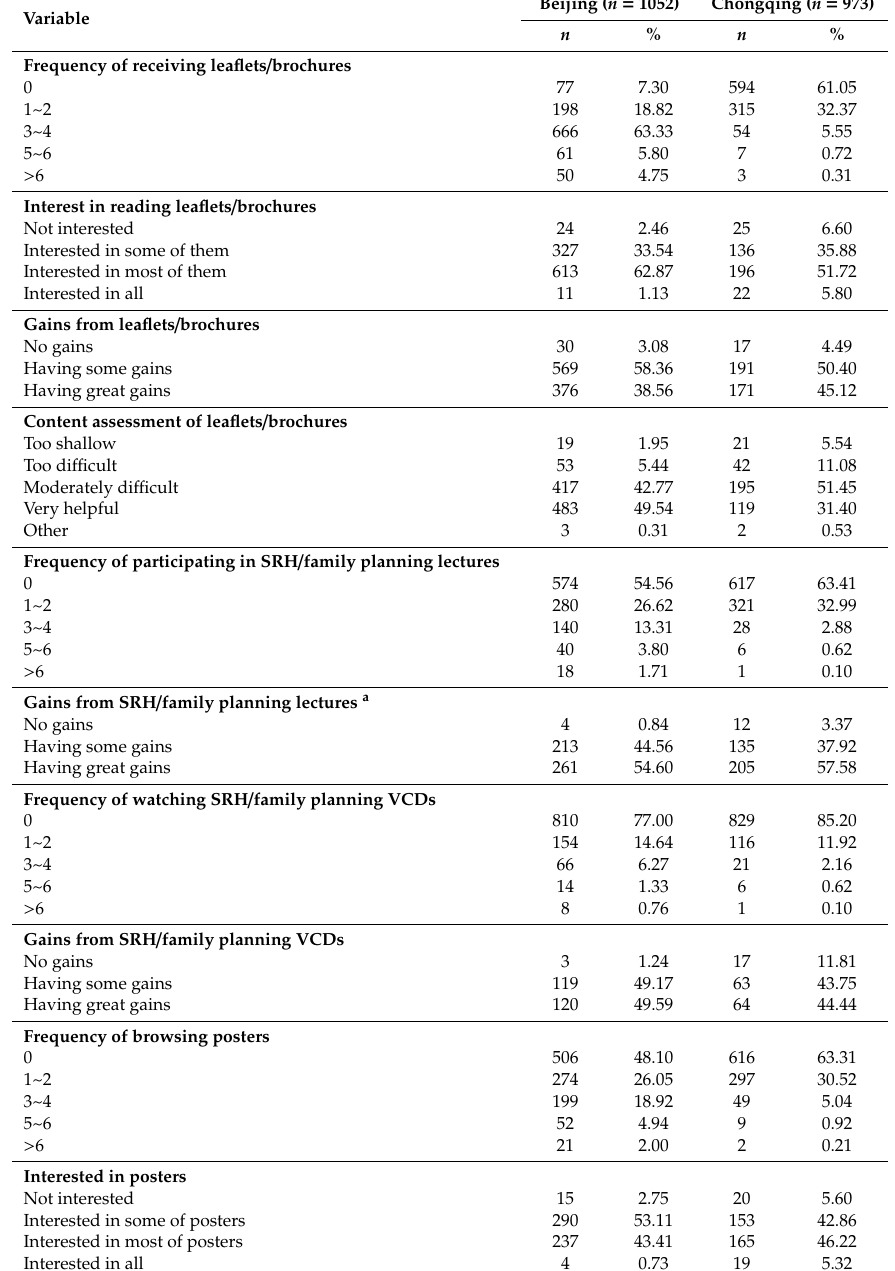
Table 1. Participation in comprehensive interventions in the intervention groups of the two cities.